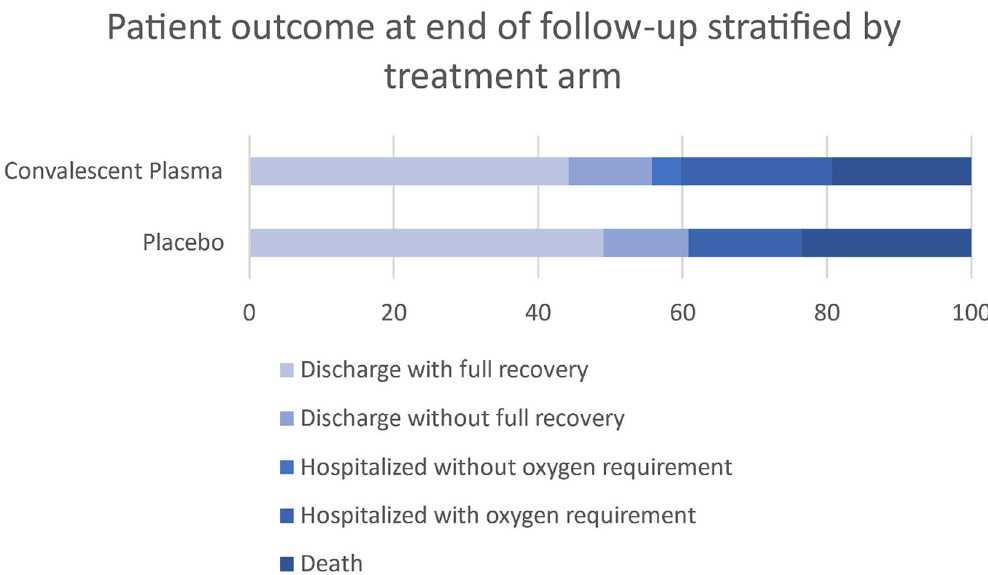
Figure 2. Proportion of clinical outcomes for 103 participants with moderate-severe COVID-19 randomized to treatment with convalescent plasma versus placebo at day 28 post